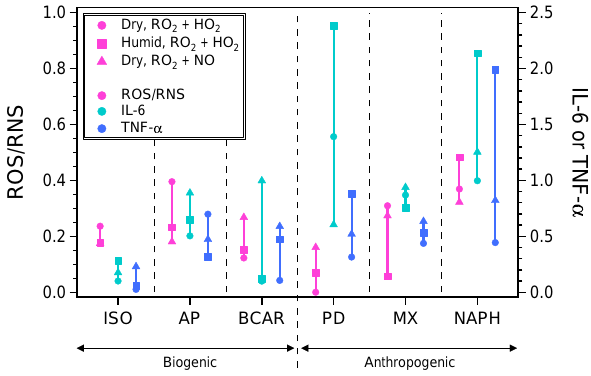
Figure 2. Area under the dose-response curve for various inflamma- tory responses induced as a result of SOA exposure: ROS/RNS, IL- 6, and TNF- α . SOA were generated from various precursors (ISO: isoprene, AP: α -pinene, BCAR: β -caryophyllene, PD: pentadecane, MX: m -xylene, and NAPH: naphthalene) under various conditions (circles: dry, RO 2 + HO 2 ; squares: humid, RO 2 + HO 2 ; and trian- gles: dry, RO 2 + NO). Lines connecting the same inflammatory re- sponse for SOA generated from the same precursor under different formation conditions are also